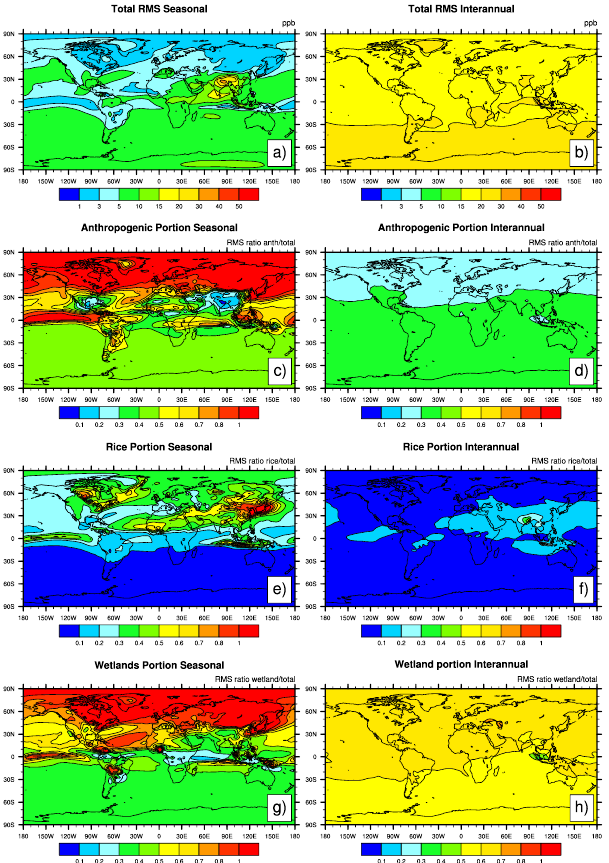
Figure 9. RMS variability (in ppb) from 1993 to 2004 of at- mospheric CH 4 concentration in BGC experiment. The left panel shows seasonal RMS variability and the right panel indicates inter- annual RMS variability. From the top to the bottom are total RMS variability (a, b) , anthropogenic contribution to total RMS variabil- ity (c, d) , rice contribution to total RMS variability (e, f) , and wet- land contribution to RMS variability (g, h) . Note that the portions of RMS variability of anthropogenic sources, rice paddies, and wet- lands add up to >1 when cancellation among component tracers occurs in the summing of total CH 4